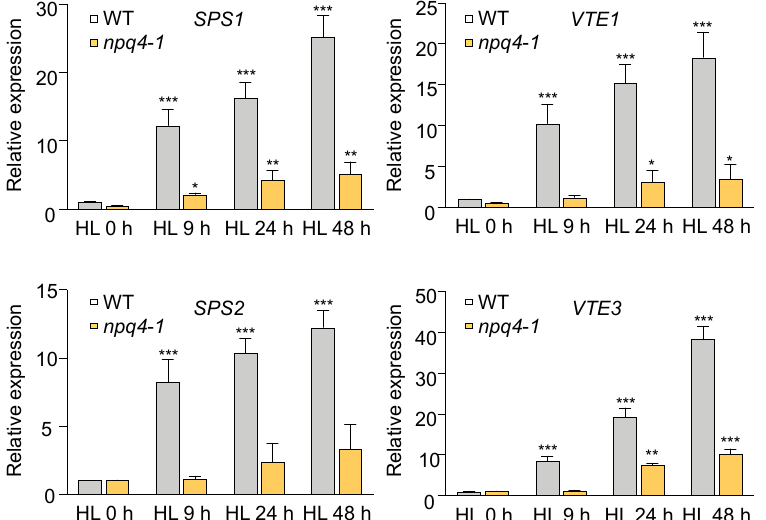
Figure 9. RT-qPCR analysis of PQ synthesis gene expression in WT and npq4-1 plants in response to HL. Four-week-old Col-0 and npq4-1 plants were treated with PPFD of 700 μ mol photons m − 2 s − 1 at 19 °C on the surface of adaxial side of the leaf. Values represent means ± SD ( n = 3 biological replicates). Significance differences are indicated by asterisks (* p < 0.05, ** p < 0.01, *** p < 0.001) compared to the HL 0 h WT as determined by one-way ANOVA with Fisher’s LSD test.